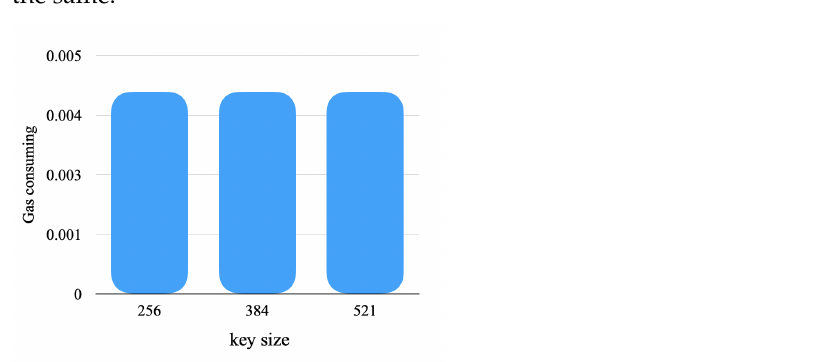
Figure 8. Encryption algorithms’ consuming gas in eth with different key size. We vary the key size (256 bits, 384 bits, and 512 bits) and measure the consumed gas for uploading the record to the blockchain. For each key size, we conduct the experiment 5 times and next take the